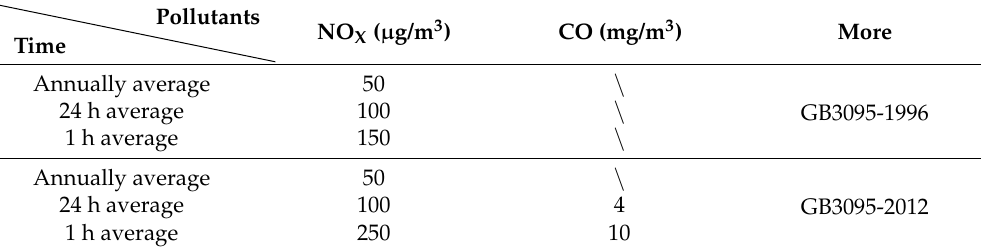
Table 6. Standard values of calculated results